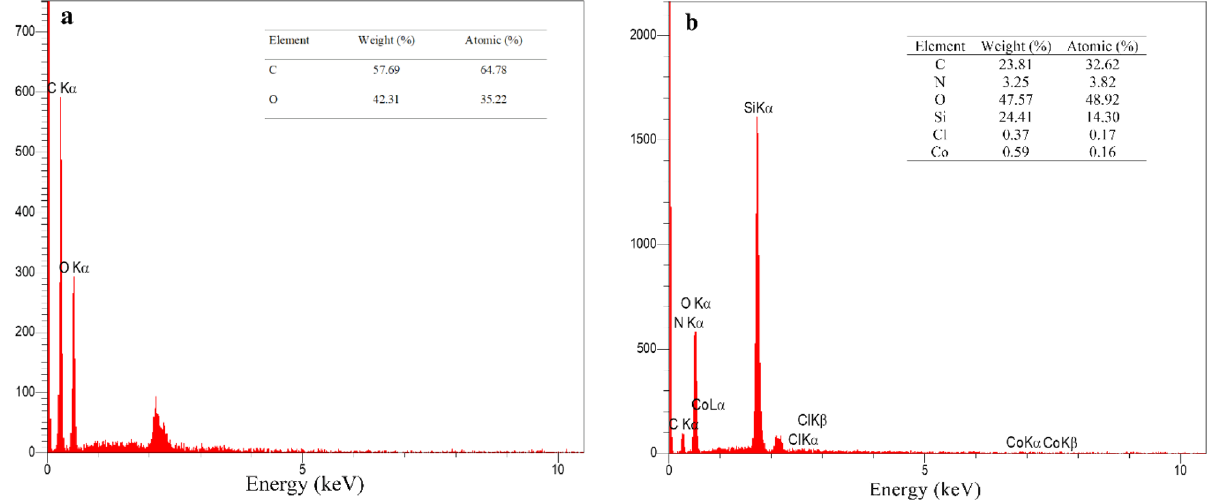
Figure 4. The EDX spectra of GO ( a ), GO/f-SiO 2 /Co ( b ).